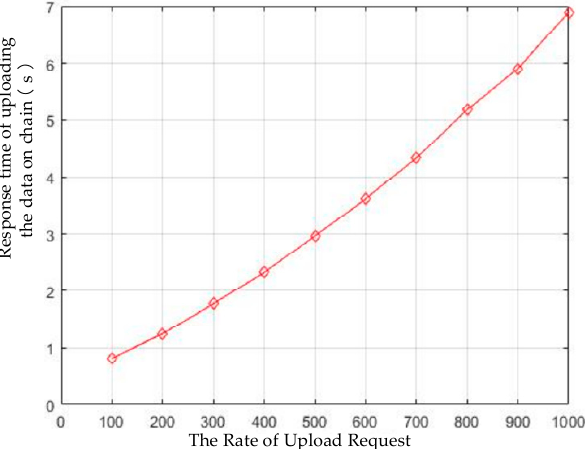
Figure 13. Response time of product data uploaded to the blockchain.